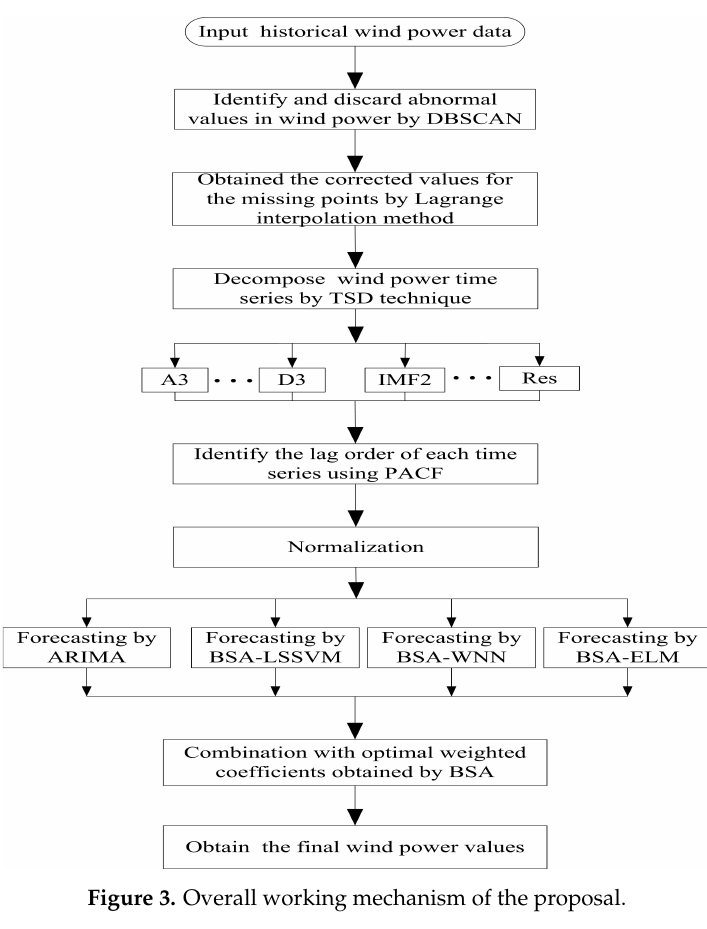
Figure 3. Overall working mechanism of the proposal.